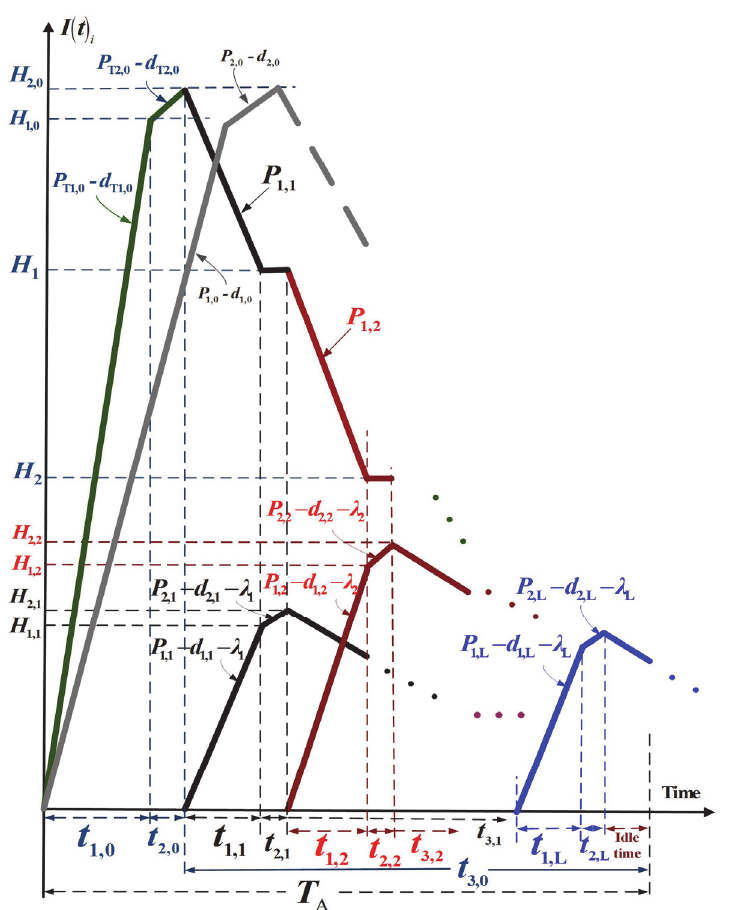
Fig. 1. The inventory status of the proposed postponement model with overtime, commonality, and quality assurance as compared with the same system without overtime option (in grey) It shows that in stage one, the common part’s stock level piles up to H 1,0 when its uptime (i.e., t 1,0 ) ends, and it reaches H 2,0 when its rework time (i.e., t 2,0 ) completes. Then, in stage two (see t 3,0 in Fig. 1), the common part’s inventory level starts to decline as the manufacturing processes of end products begin. finished item i . Meantime, for each end-product i (where i = 1, 2, …, L ), the stock level piles up to H 1,